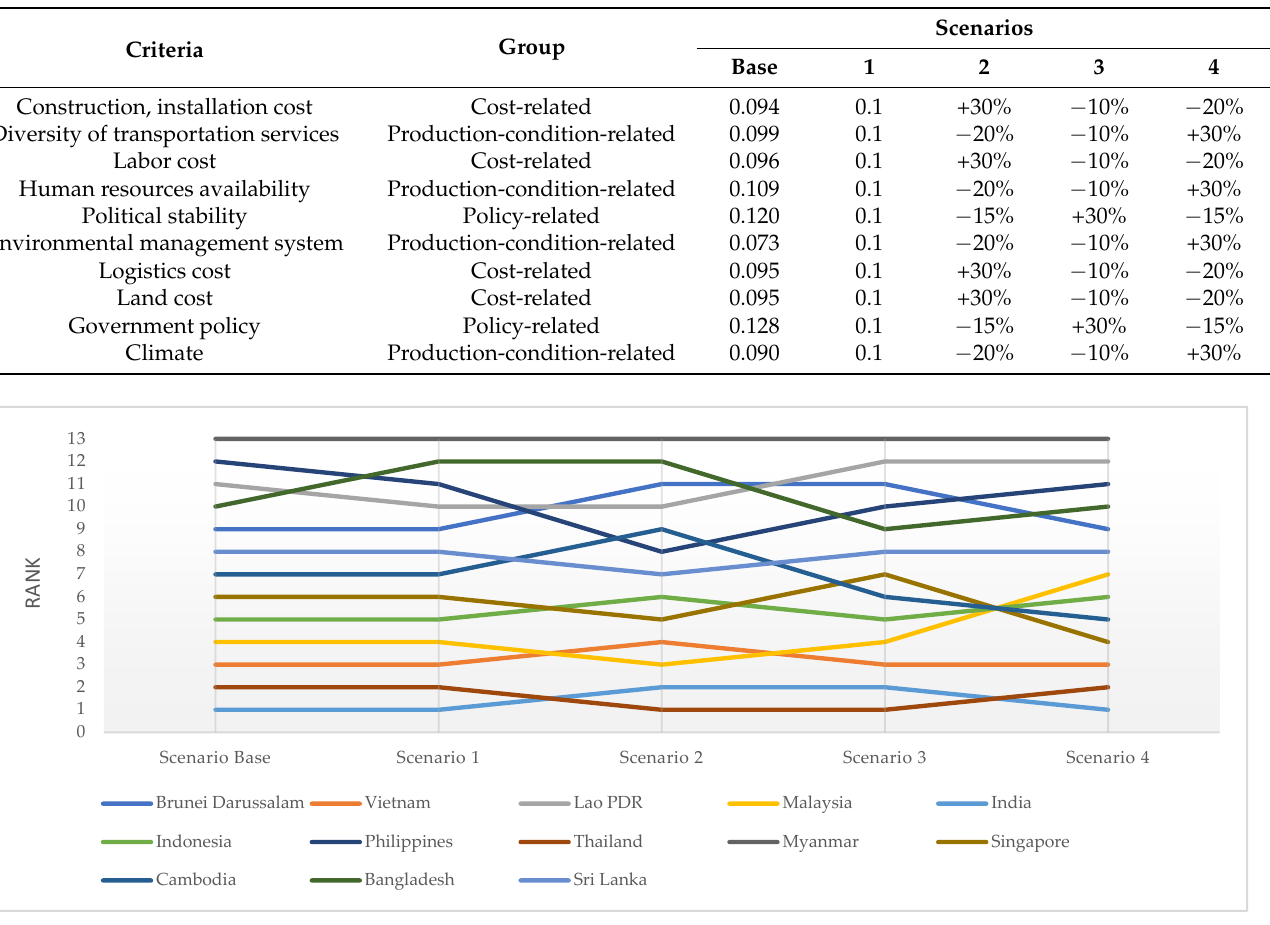
Figure 7. Weighting scenario analysis.